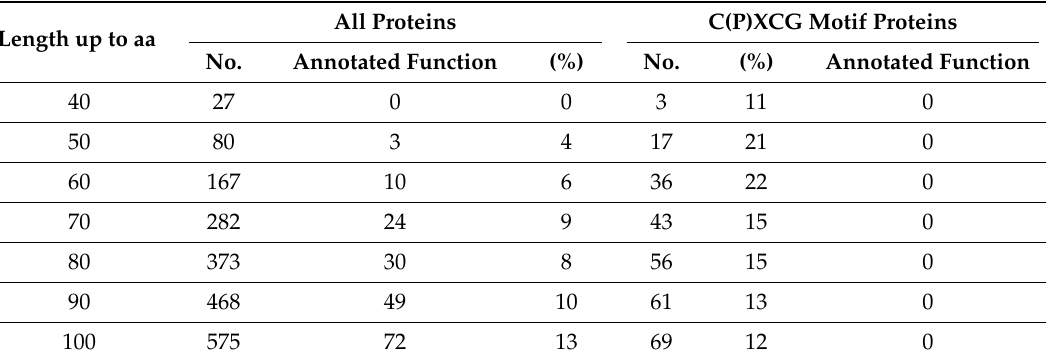
Table 1. Length distribution of small proteins encoded in the genome of H. volcanii